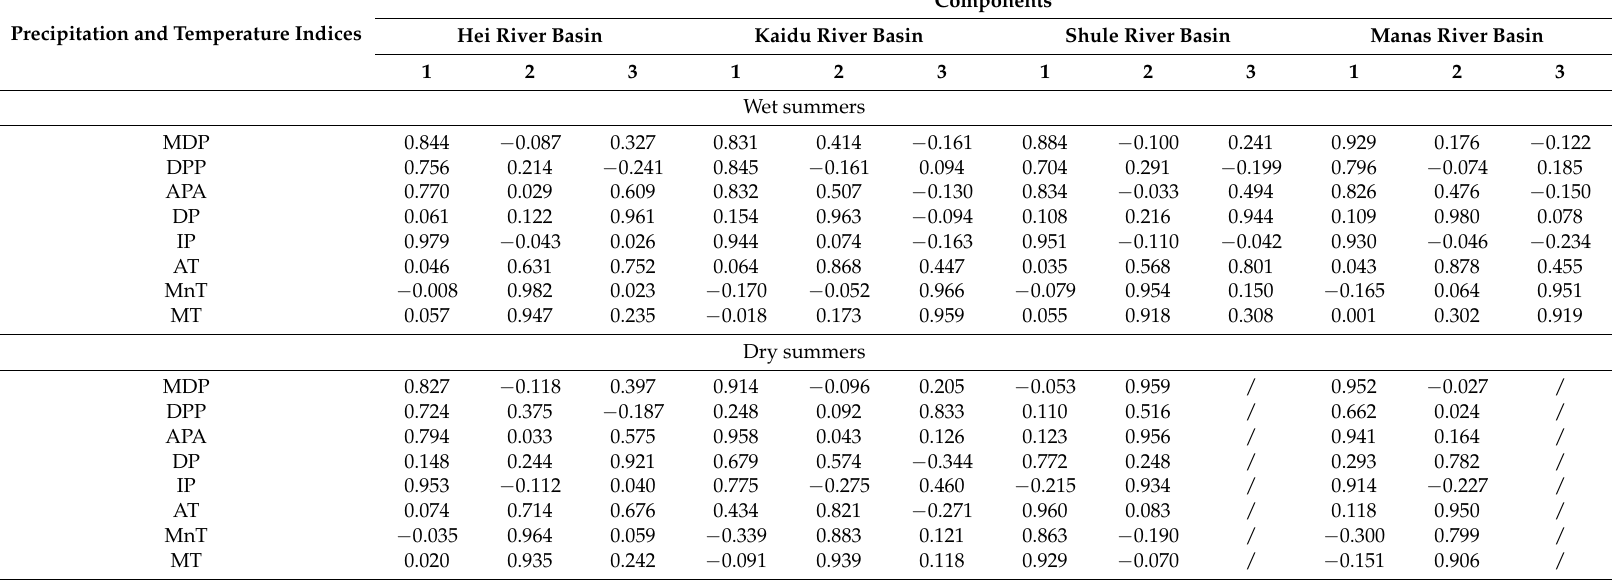
Table 4. Loading matrix results for the vectors of the retained components on precipitation and temperature indices for each selected basin during wet and dry